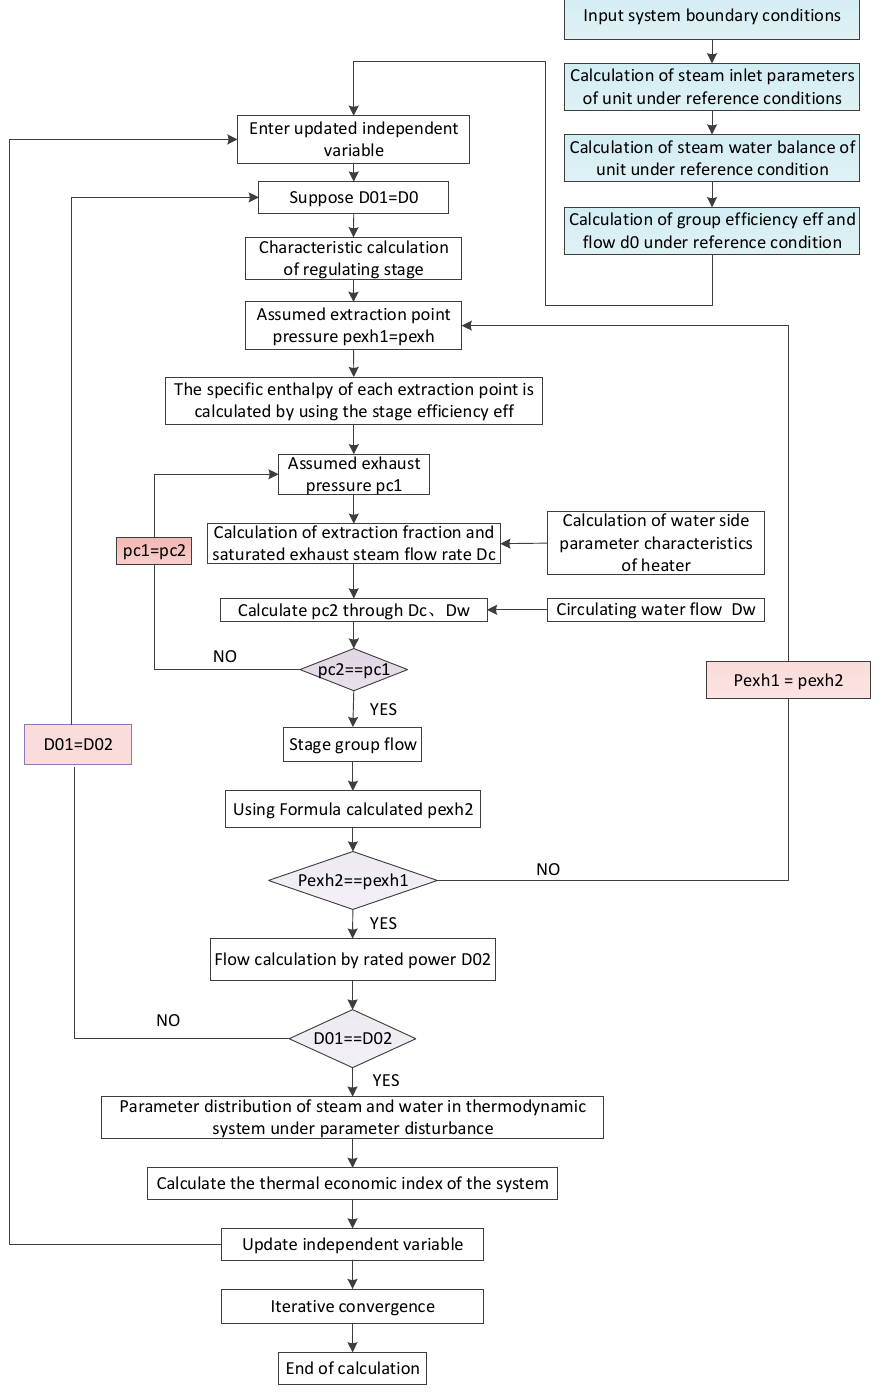
Figure 1. Logical flowchart of the performance prediction model.